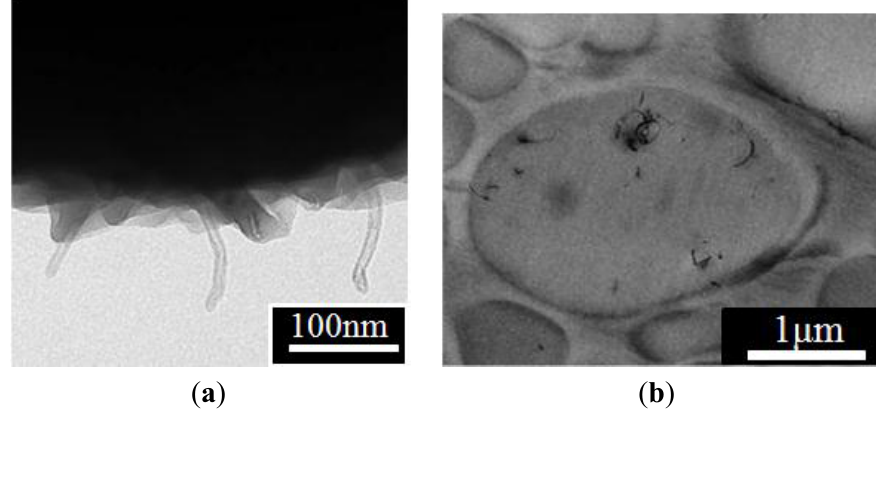
Figure 8. TEM image of ( a ) surface and ( b ) cross section of MWNT/PMMA composite particles (reprinted with permission from [33], Copyright 2007